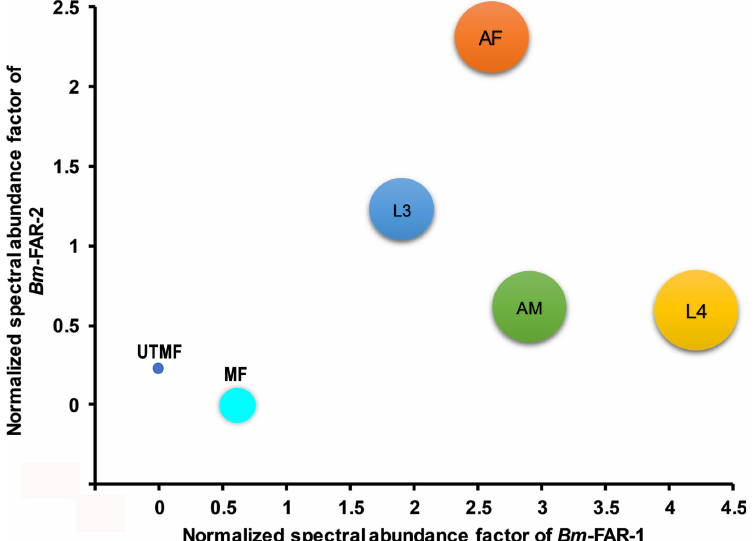
Fig 2. Bubble plot showing the normalized spectral abundance levels of BmFAR-1 and BmFAR-2 across the mature microfilaria (MF), immature microfilariae (UTMF), L3 larvae, in-vitro derived L4 larvae (L4), adult female (AF) and male (AM) worms based on proteomic analysis. The size of the bubble is proportional to the abundance of